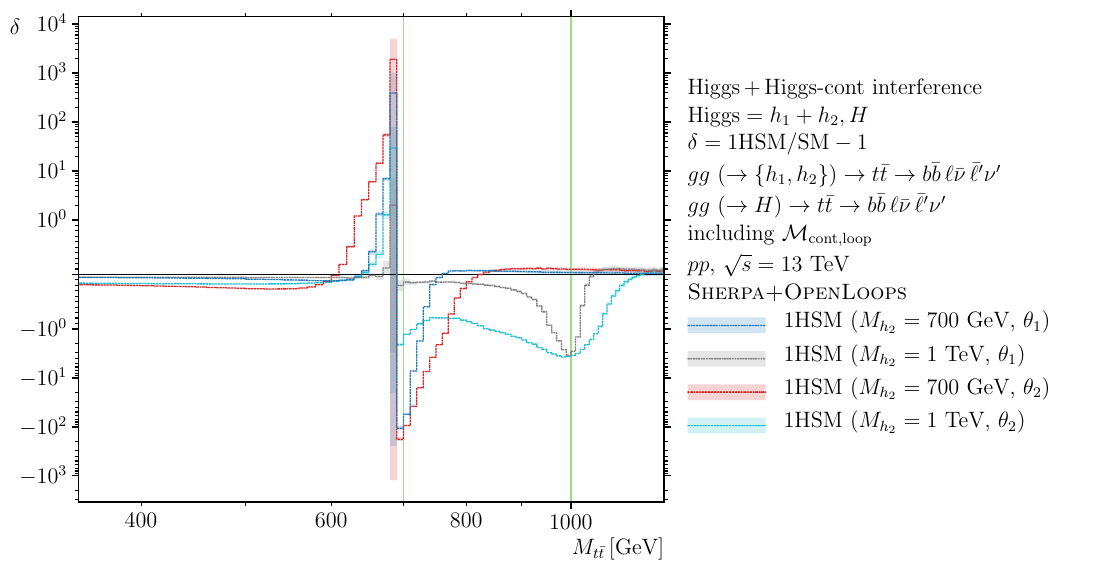
Figure 19 . M its interference with the background in the 1HSM ( M h the SM for gg ( σ ( h 1+2 +I(C + (cid:31) )) to σ ( H +I(C + (cid:31) )). Other details as in figure